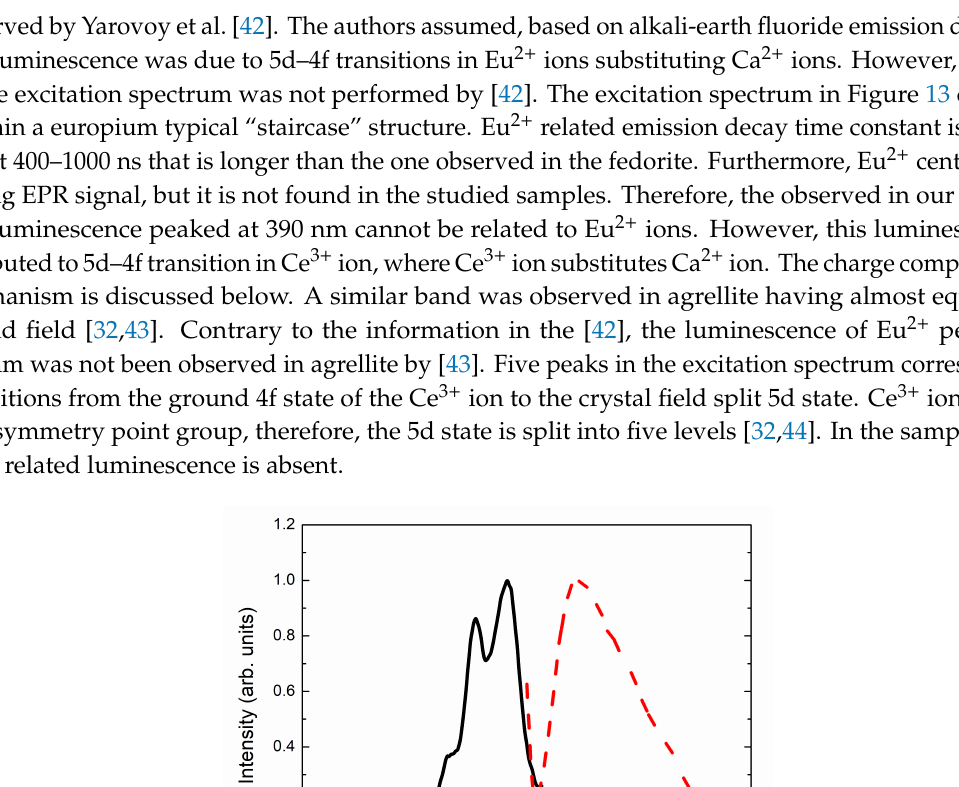
intense peak at 255 nm and the fundamental absorption edge at 230 nm are found.